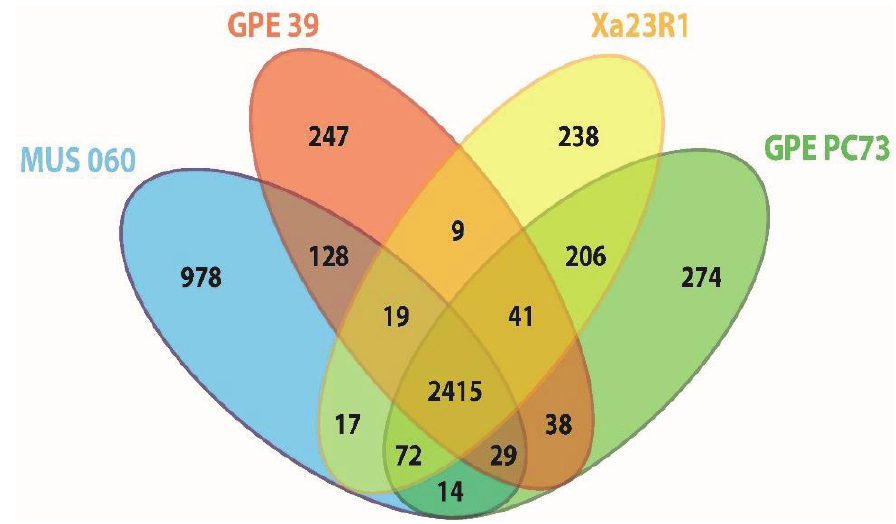
Figure 2. Venn diagram showing the number of orthologous proteins (OrthoMCL groups) shared by proteomes of strains of X. albilineans and “ X. pseudalbilineans ” species (numbers shown do not include paralogous protein sequences). The number of specific elements of each proteome is the sum of specific inparalog groups and of specific single copy proteins of this proteome. GPE PC73: X. albilineans strain GPE PC73, Xa23R1: X. albilineans strain Xa23R1, GPE 39: “ X. pseudalbilineans ” strain GPE 39 and MUS 060: “ X. pseudalbilineans ” strain MUS